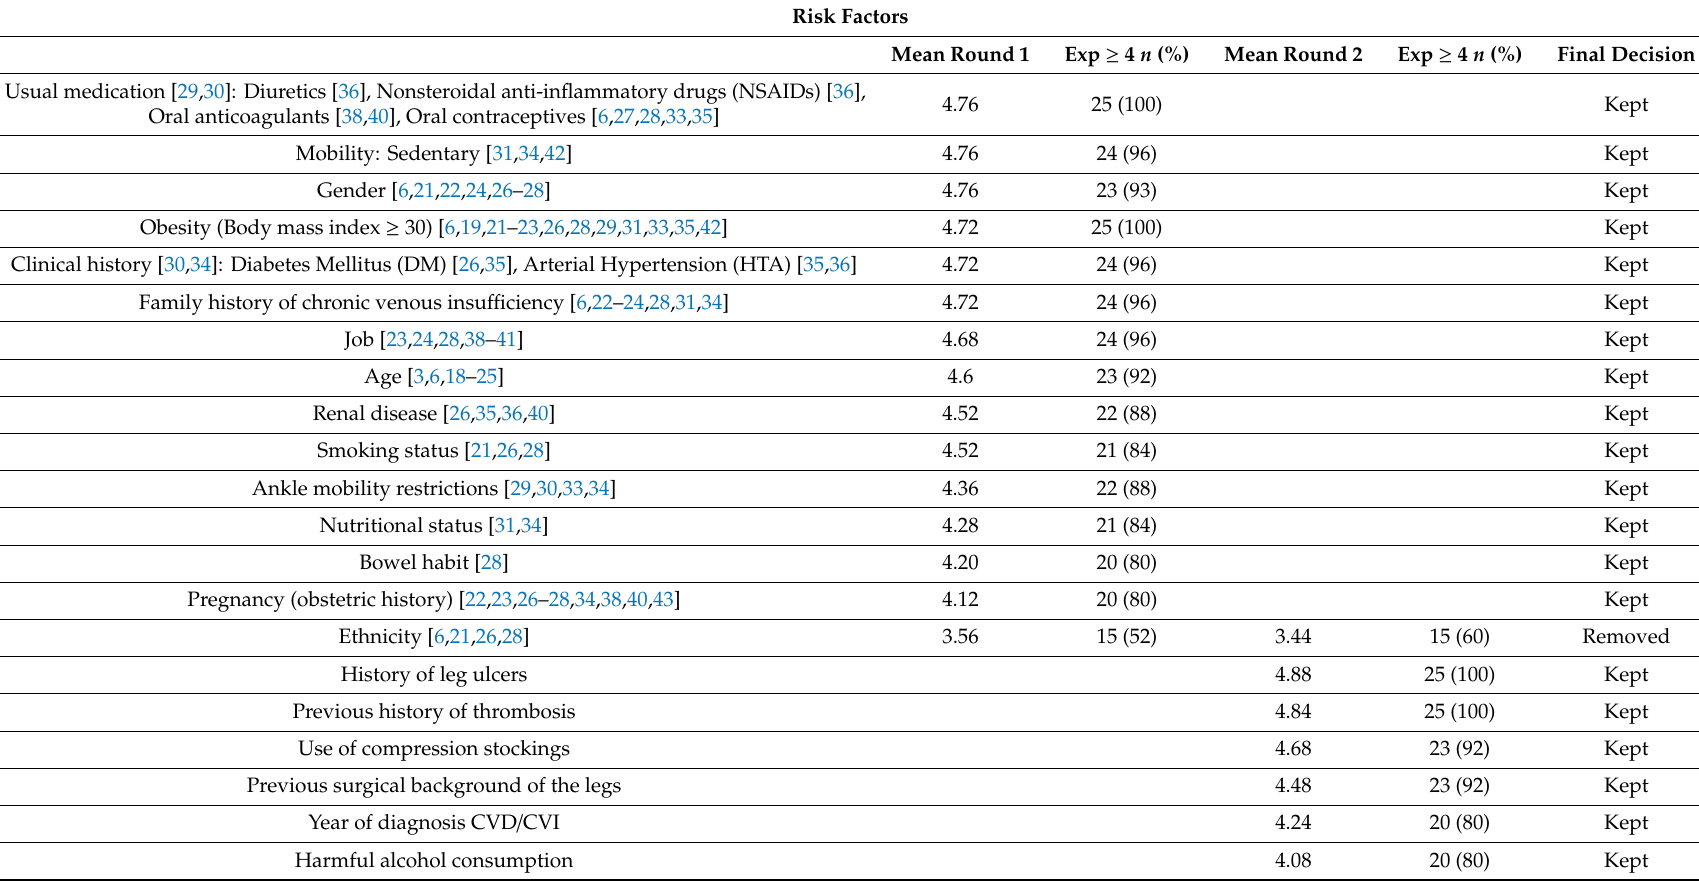
Table 1. Items related to risk factors and patient’s leg